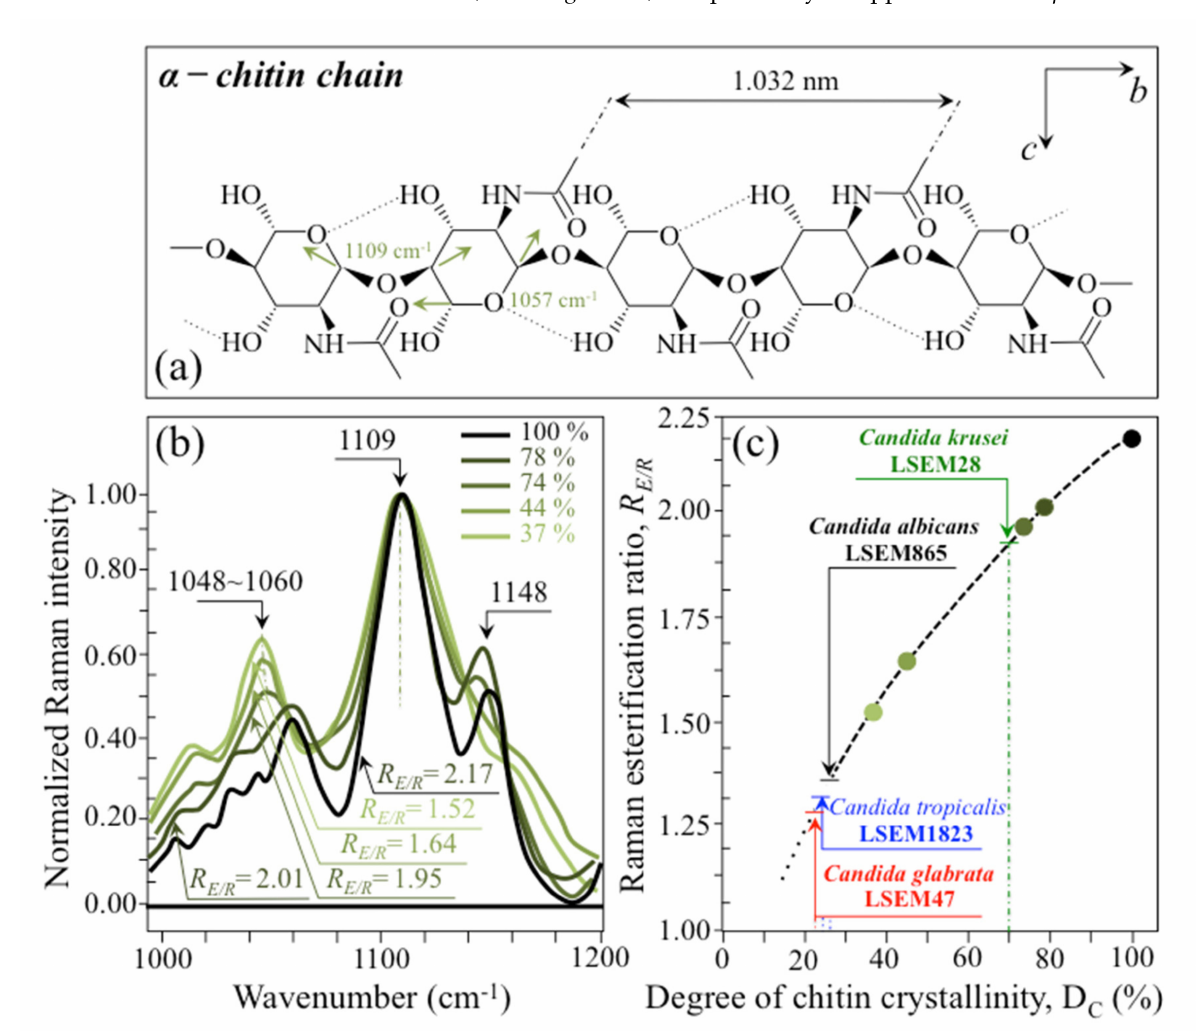
Figure 5. ( a ) Schematic draft of the chitin chain with its ester and ring vibrational modes; ( b ) Raman spectra of a series of chitin compounds with decreasing chain lengths in comparison with the spectrum of a reference (fully crystalline) α -chitin compound [66] (labels in inset show band wavenumbers in cm − 1 , crystallinity values by wide-angle X-ray diffraction measurements in %, and R E/R values as calculated from the Raman spectra); in ( c ), plot of the R E/R ratio as a function of percent degree of chitin crystallinity, D C , according to which the studied Candida species were evaluated (cf.